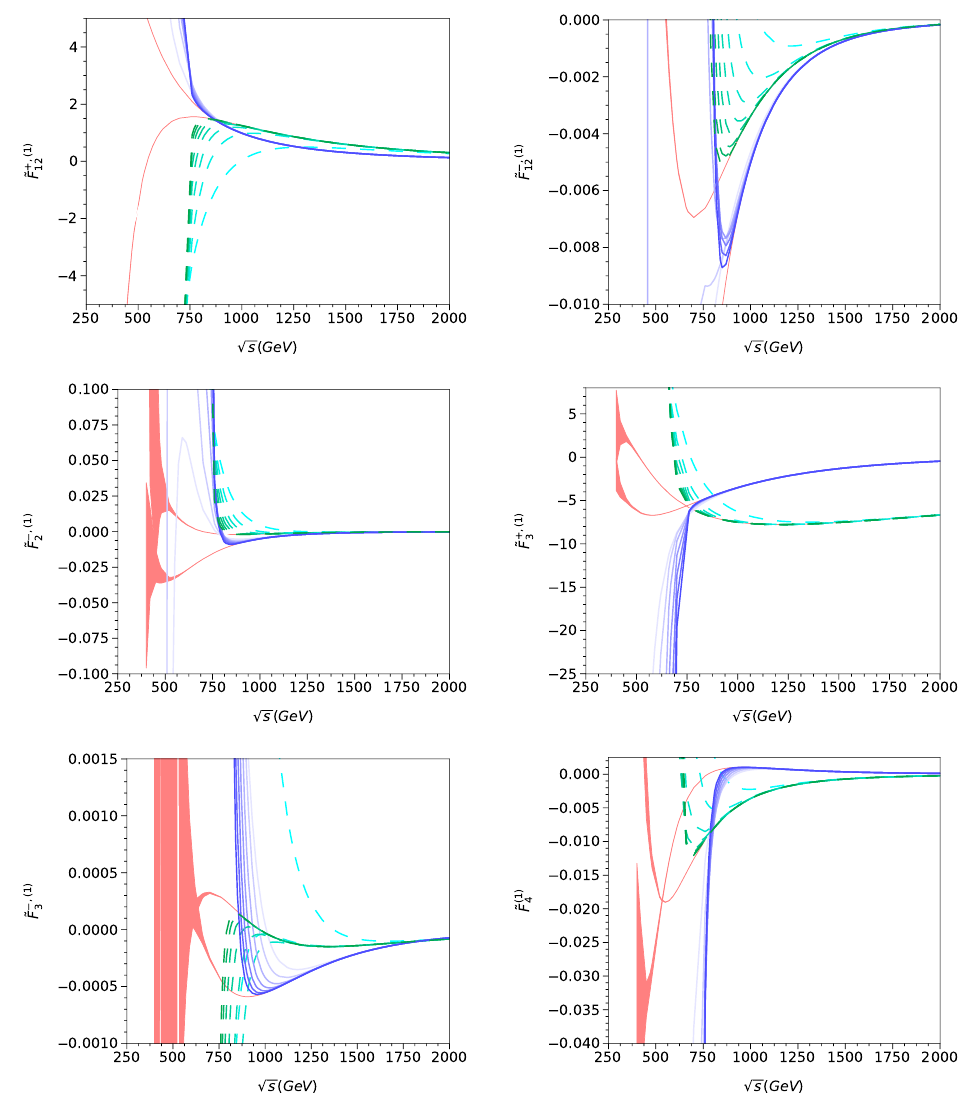
√ s for fixed θ = π/ 2 .